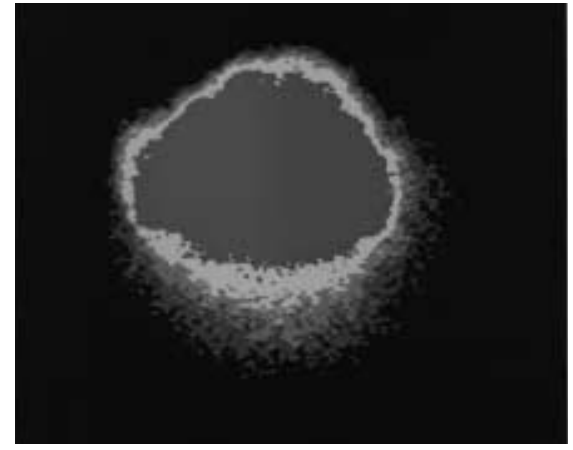
X-ray image of a bubble in a fluidized bed of a Group B powder